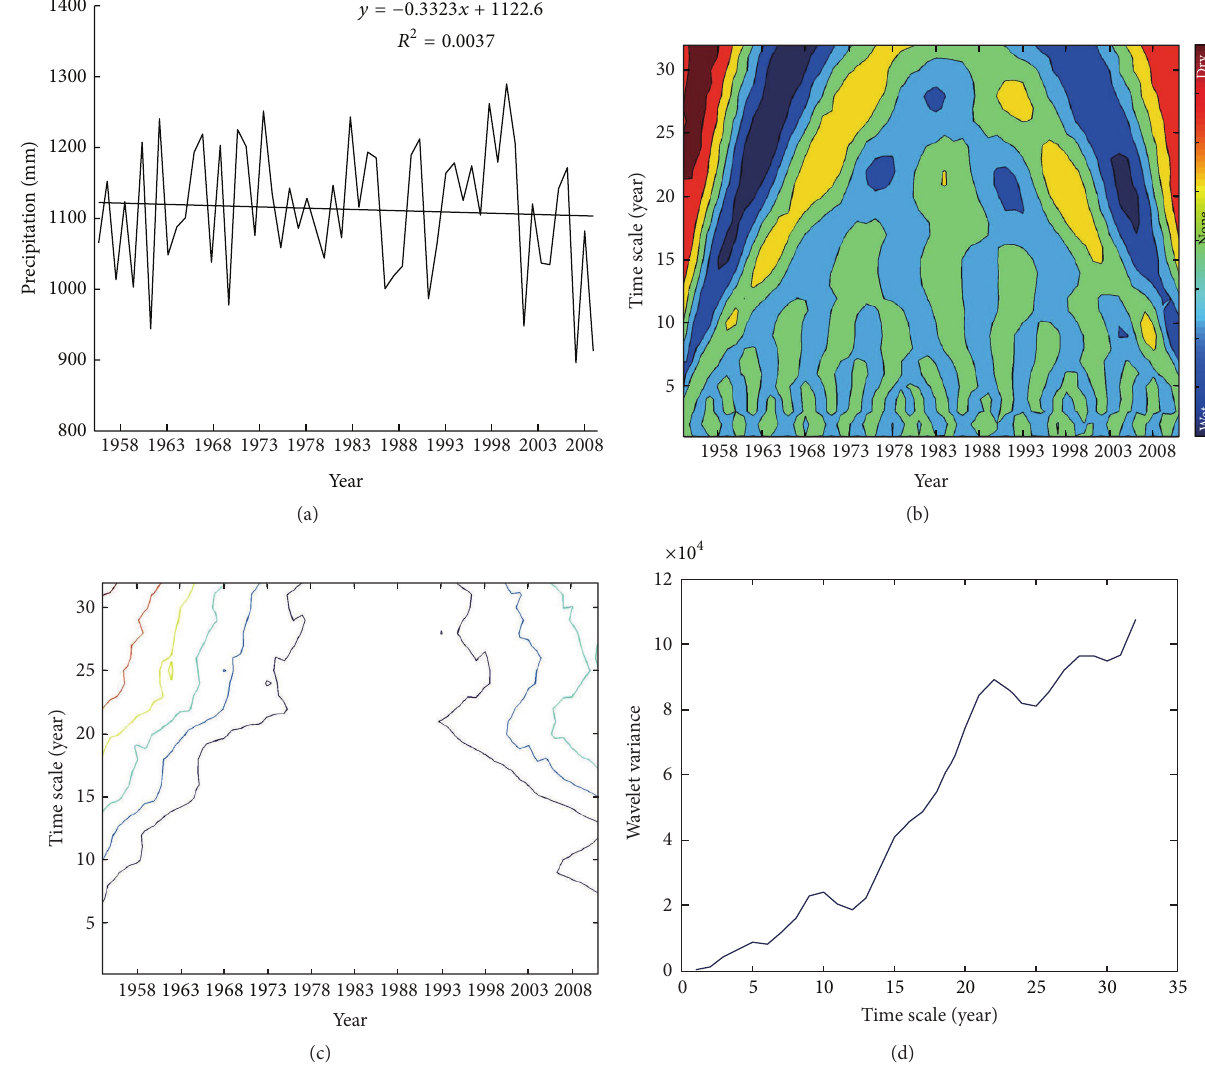
Figure 6: (a) Annual precipitation interannual change of Yunnan. (b) Annual precipitation wavelet transform of Yunnan. (c) Annual precipitation wavelet coefficients contour of Yunnan. (d) Annual precipitation wavelet variance of